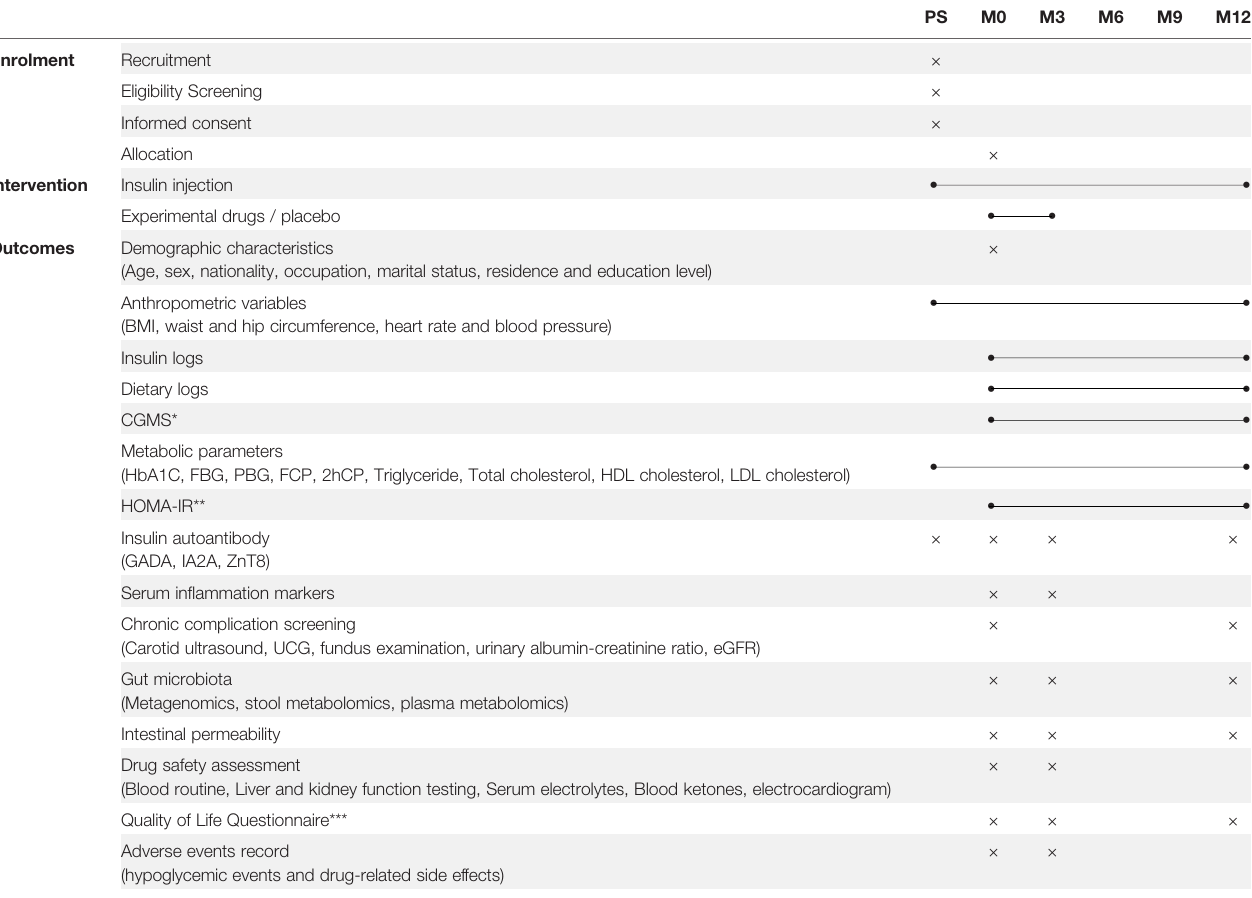
TABLE 1 | Patient fl ow of enrolment, intervention and outcome